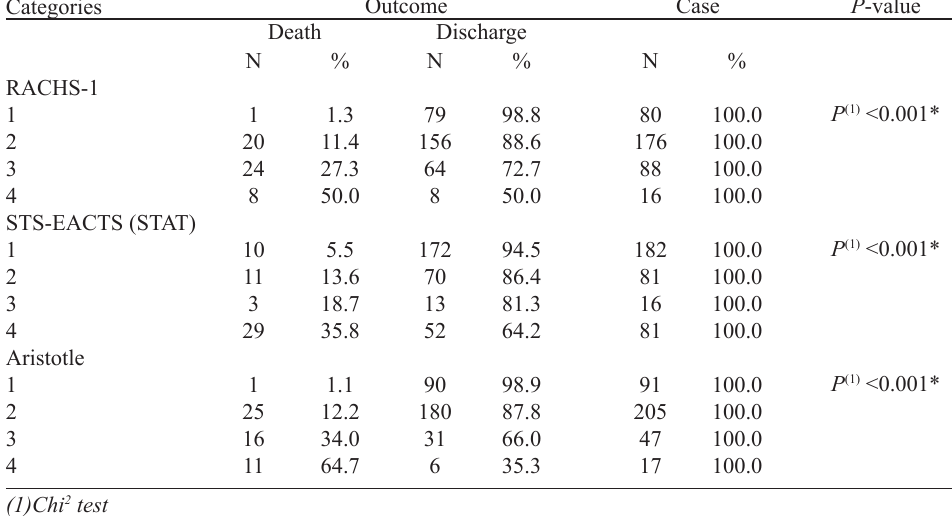
Table 4. In-hospital mortality according to the categories of the three models of risk